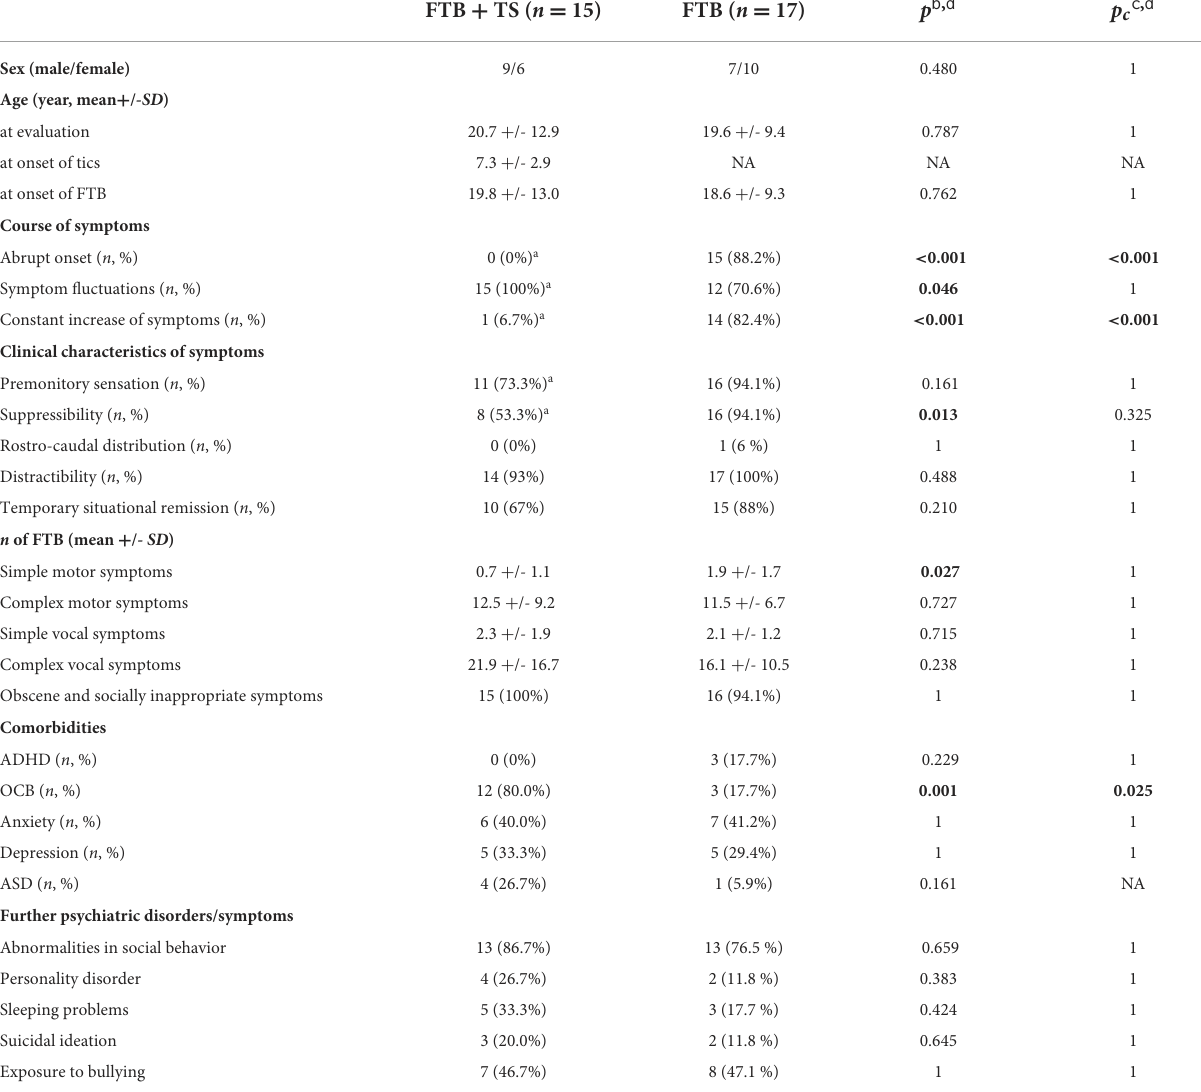
TABLE 4 Patients with MSMI-FTB with comorbid TS ( n = 15) compared to those without comorbid TS ( n =